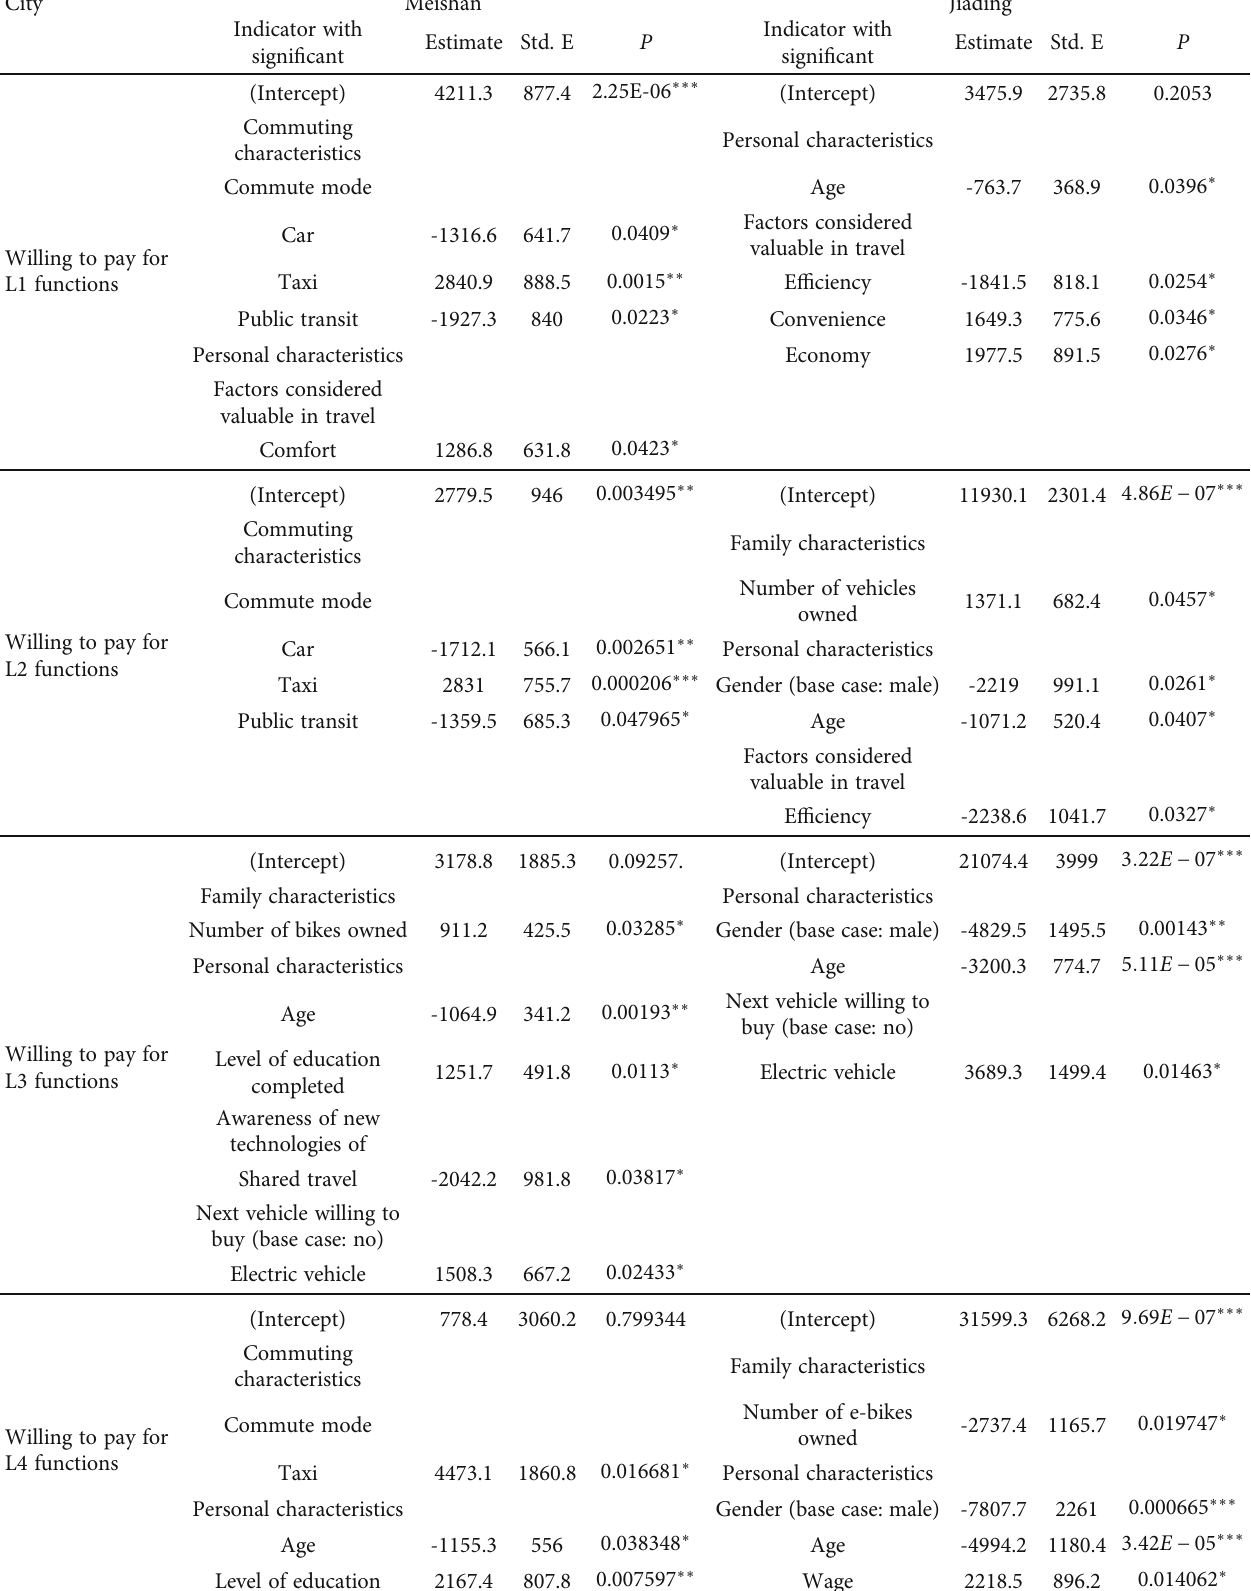
Table 8: Linear model for willingness to pay for di ff erent levels of ADAS or autonomous driving functions.